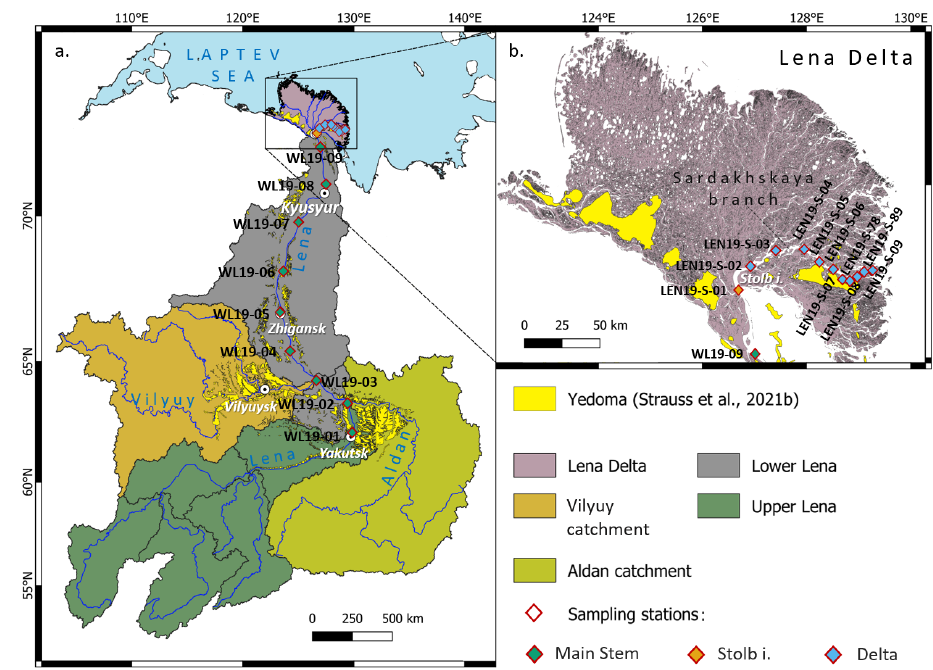
Figure 1. The Lena River catchment and its delta, with Yedoma distribution (Strauss et al., 2021b) in the catchment area. (a) Sampling locations along the Lena River main stem ( n = 9) and the Lena River catchment area; (b) sampling locations at Stolb Island ( n = 3) and in the Lena delta along the Sardakhskaya branch ( n =